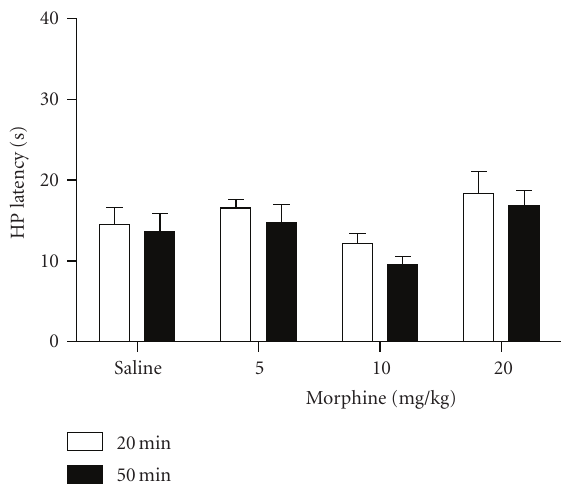
Figure 2: Changes in nociception following microinjection of deltorphin into the vPAG. Nociception was assessed 20 and 50 minutes after deltorphin microinjection into the vPAG of rats made tolerant to morphine. Pretreatment with morphine produced a slight decrease in hot-plate latency in rats made tolerant to 10mg/kg of morphine compared to the slight increase in rats made tolerant to 20 mg/kg of morphine, although neither of these changes di ff ered significantly from the e ff ects of deltorphin administration in saline- pretreated controls. All rats were tested on the hot plate 20 minutes after deltorphin microinjection (see sample sizes in the caption of Figure 1), but only a subset was tested at 50 minutes for the saline ( N = 9), 5 ( N = 5), 10 ( N = 10), and 20 ( N = 8)mg/kg morphine